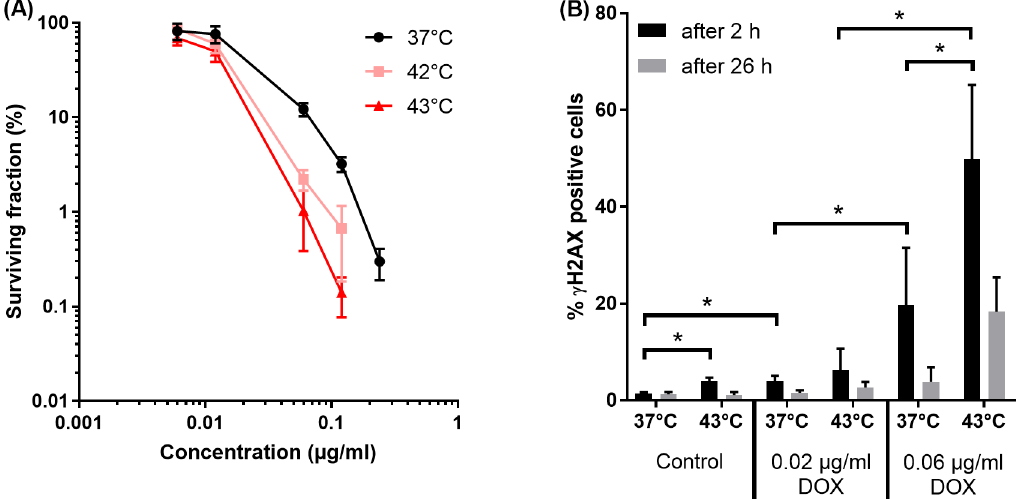
Fig 5. Cytotoxicity of hyperthermia at different temperatures and DOX. (A) Surviving fraction as function of DOX concentration for 1 hour at 37, 42 or 43˚C. Cells were exposed for 1 hour to DOX at 37, 42 and 43˚C. Both 42 and 43˚C showed enhancement cytotoxicity of the DOX, which was the largest at 43˚C. (B) Percentage γ H2AX positive cells 2 and 26 hours after incubation with DOX (0, 0.02 or 0.06 μg/ml) for 1 hour at 37˚C or 43˚C. HT enhanced the percentage γ H2AX positive cells both 2 and 26 hours after